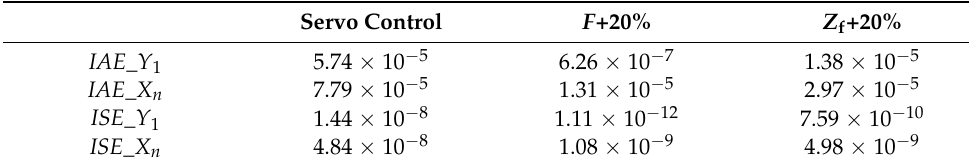
Table 6. Error index of GMC in Case 2.